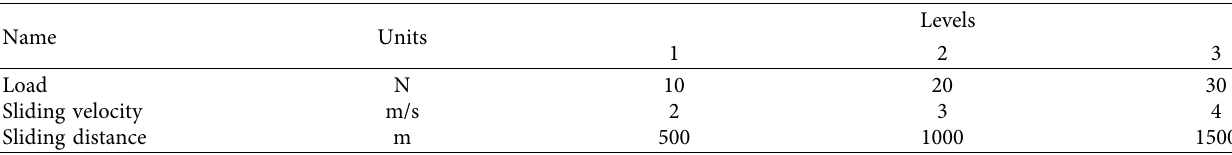
Figure 5: BHN vs. treated and untreated SGFs with polyester. Table 1: Level of factors.